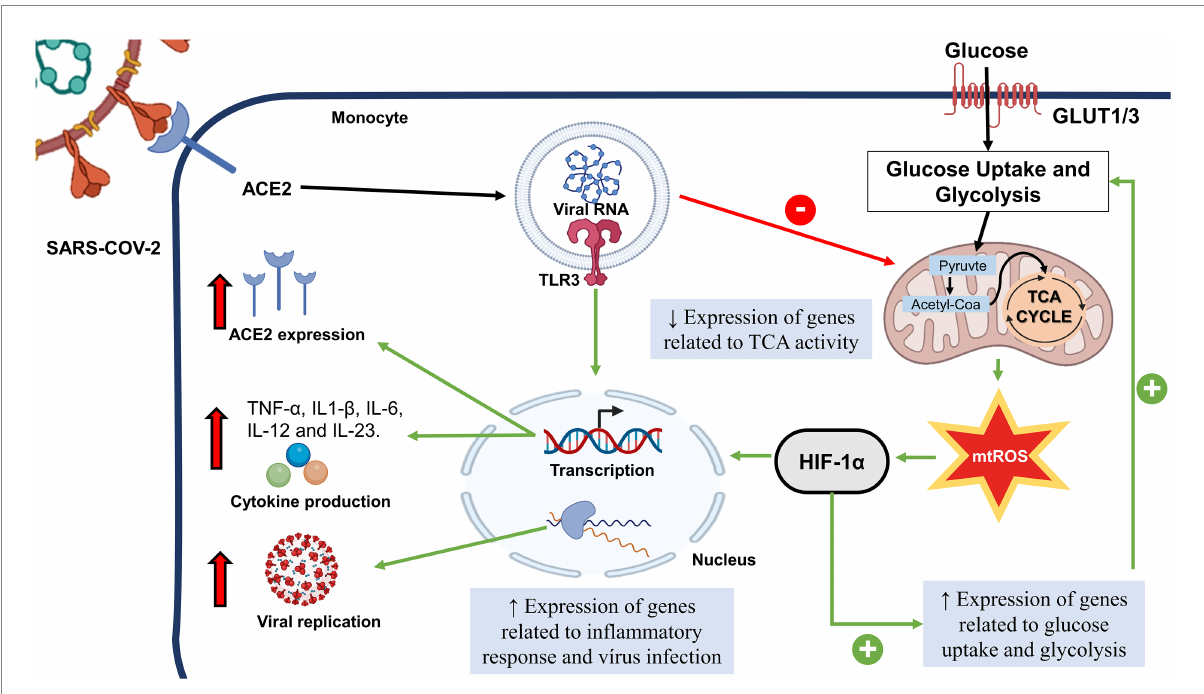
FIGURE 1 Possible Role of Sars-Cov-2 in Monocyte Metabolism. After the interaction of SARS-COV-2 with ACE2, the viral fragment binds to TRL3, leading to the decrease of genes related to TCA activity. There is a mtROS increase and HIF-1 α activation, followed by the increase of genes related to glucose uptake. HIF-1 α and TLR3 leads to transcription of genes related to pro-inflammatory cytokines, expression of ACE2 and genes related to response to virus infection and viral replication. SARS-CoV-2, Severe Acute Respiratory Coronavirus 2; HIF-1 α , Hypoxia inducible factor-1 α ; TCA, citric acid cycle; GLUT, glucose transporter; mTROS, mitochondrial reactive oxygen species; TLR, toll like